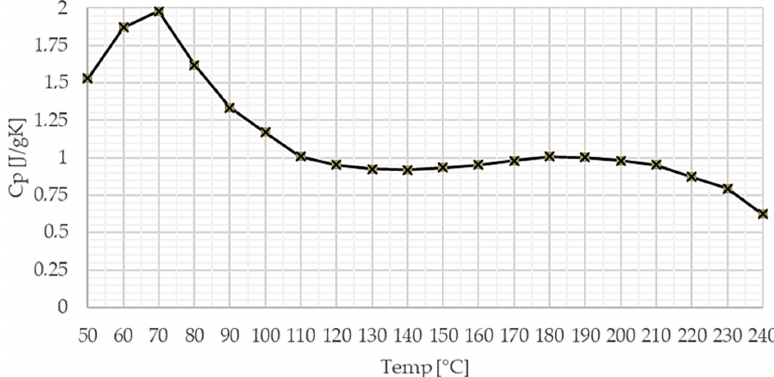
Figure 19. Specific heat capacity of the investigated facing material versus temperature.